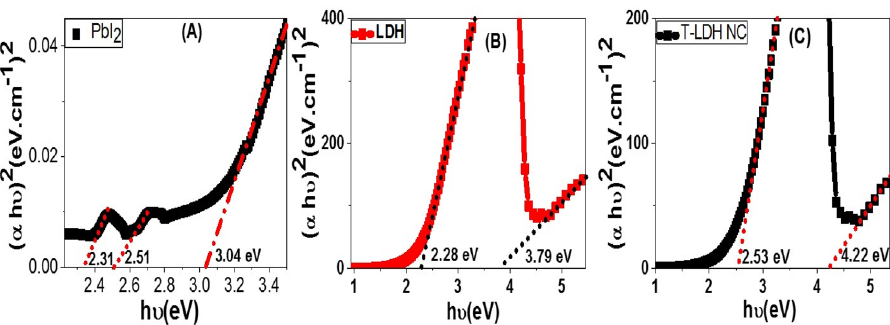
Figure 6. (αh ʋ ) 2 vs. h ʋ for energy gap calculation of (A) PbI 2 , (B) Co–Cd–Fe LDH, and (C) T-LDH/PbI 2